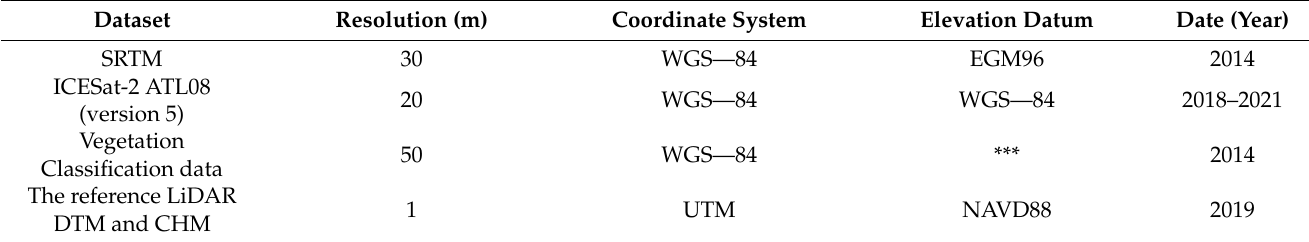
Table 1. The information about the datasets used in this